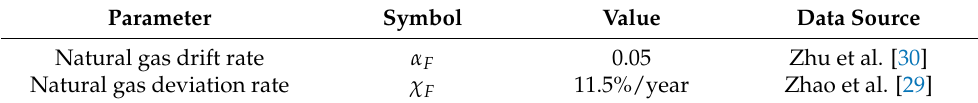
Table 4. Parameters and the descriptions during the gas price